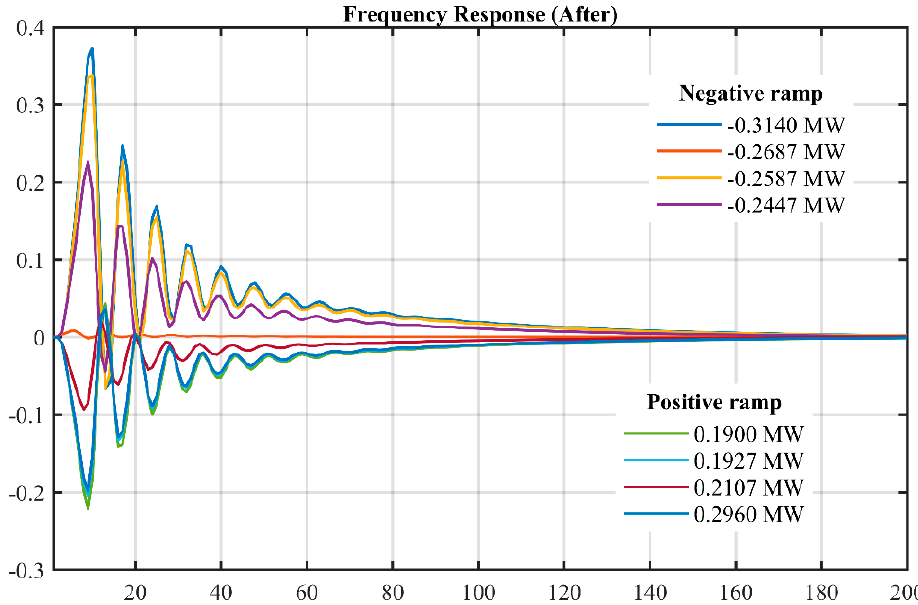
Figure 11. Transient response of the multi-machine power system with BESS.